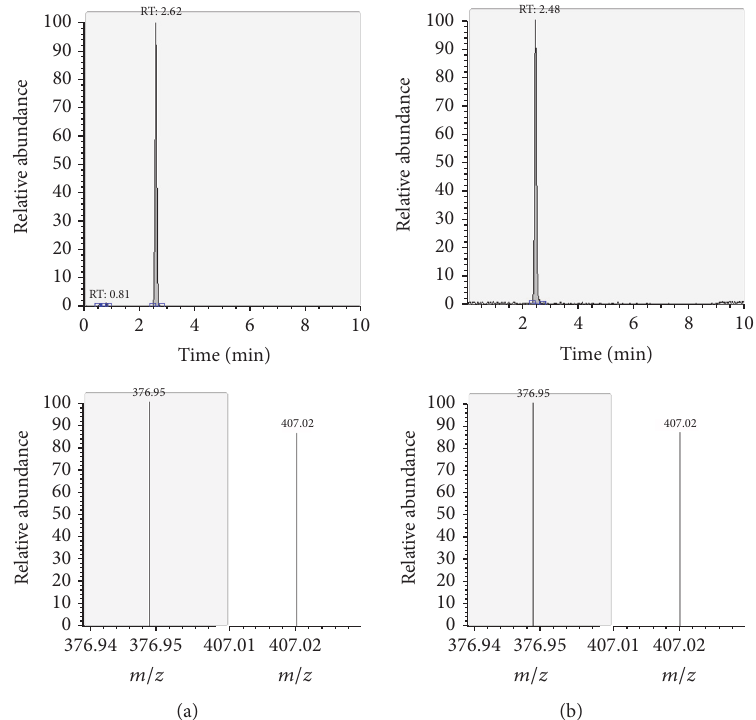
Figure7:LC-MS/MSchromatogramsofBCLandSRMtransitionsandrelativeabundances.(a)Standardina100 𝜇 g L −1 solution.(b)Standard in the spiked sample at 100 mgkg −1